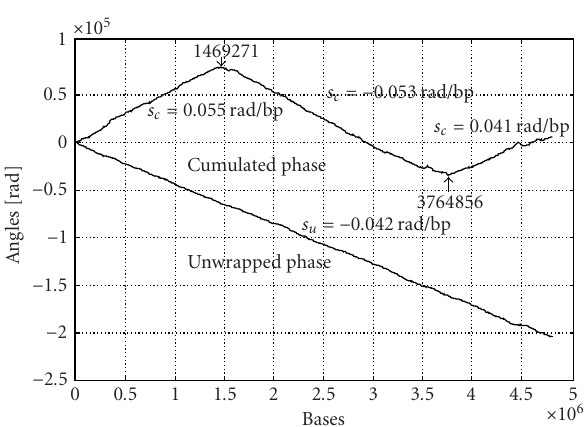
Figure 4: Cumulated and unwrapped phases for the genomic signal of the complete chromosome (4809037 bp) of Salmonella typhi [13] (accession AL5113382 [12]).